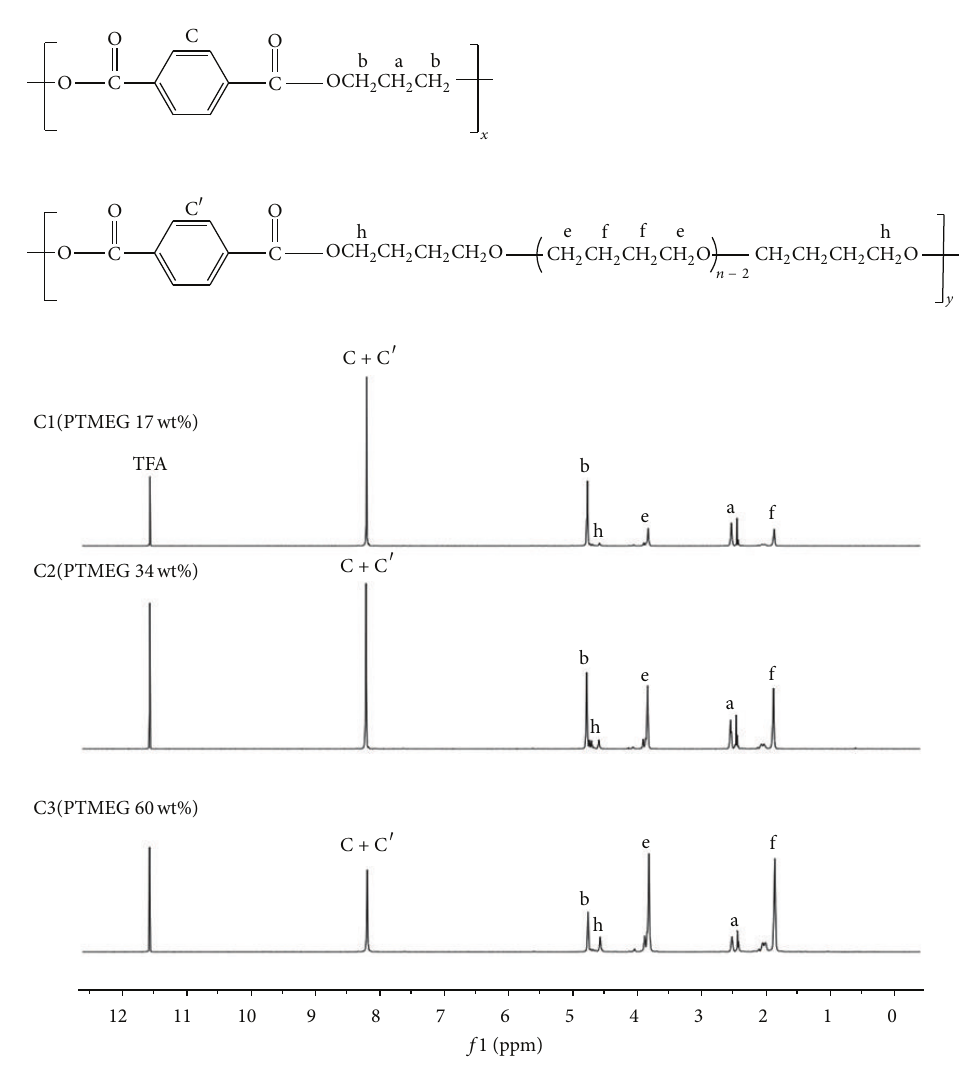
Figure 2: 1 H NMR spectra of PTT-PTMEG copolymers.